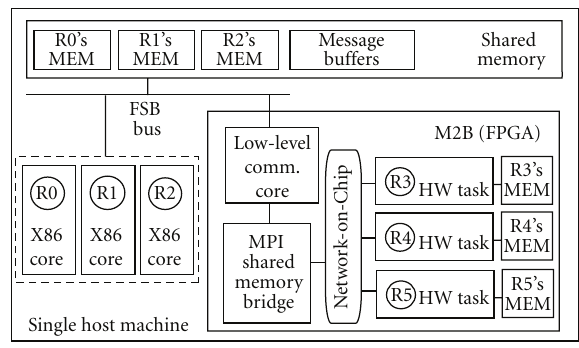
Figure 2: Example of a 6-rank MPI application, with three ranks mapped to X86 processor cores and three ranks mapped to hardware